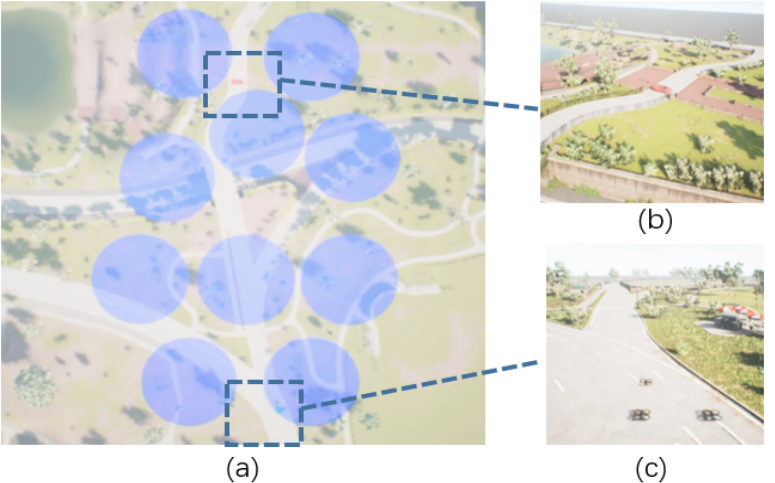
Figure 3. Scenario of multi-UAV path planning. ( a ) is the top view, ( b ) is the target position, and ( c ) is the initial position of the multi-UAV. The blue area is the defensive area, which is only used as a schematic for the reader, and it is not visible in the actual training and flight.